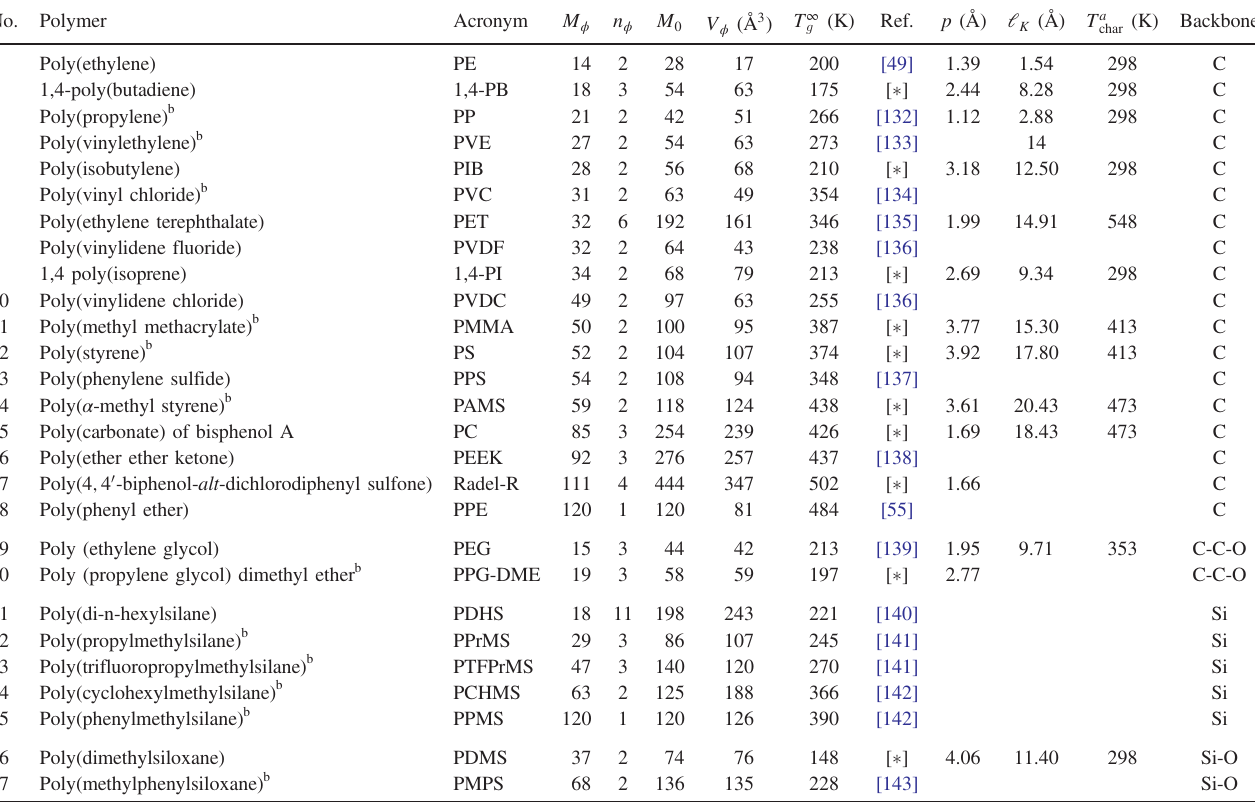
TABLE V. Table of molecular weights (in g/mol) and volumes per conformer, ordered in increasing mass per total conformer (i.e., including the side groups but excluding methyl groups) and separated according to backbone chemistry.